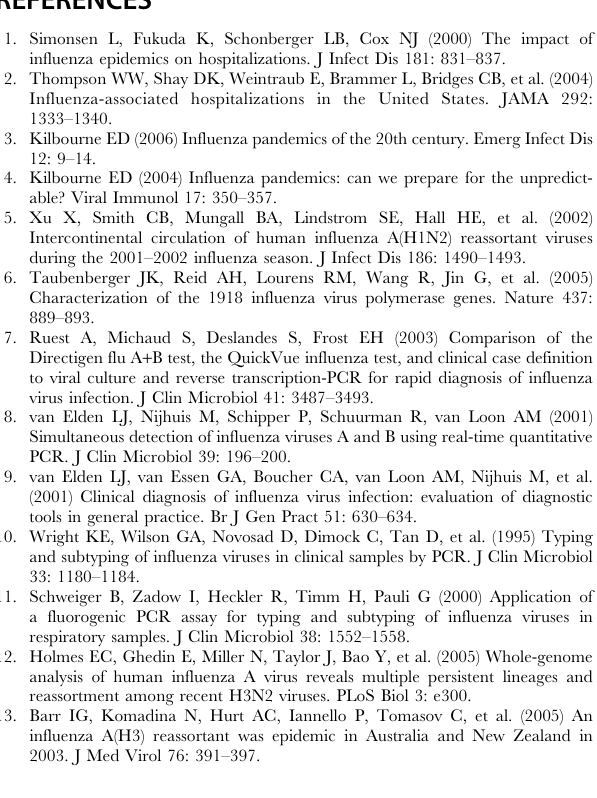
Table S3 Mutations observed in influenza virus isolates in 2005– 06 season. Out of the 174 influenza A H3N2 positive samples analyzed from the 2005–2006 season, 29 genotypes were assigned based on RT-PCR/ESI-MS and 30 were assigned based on sequencing. There were no instances of ‘‘ESI-MS silent’’ compensating double mutations (e.g., simultaneous A . G and G . A within the same amplicon leading to no change in the observed BC-type) as verified by sequencing. Found at: doi:10.1371/journal.pone.0000489.s003 (0.10 MB